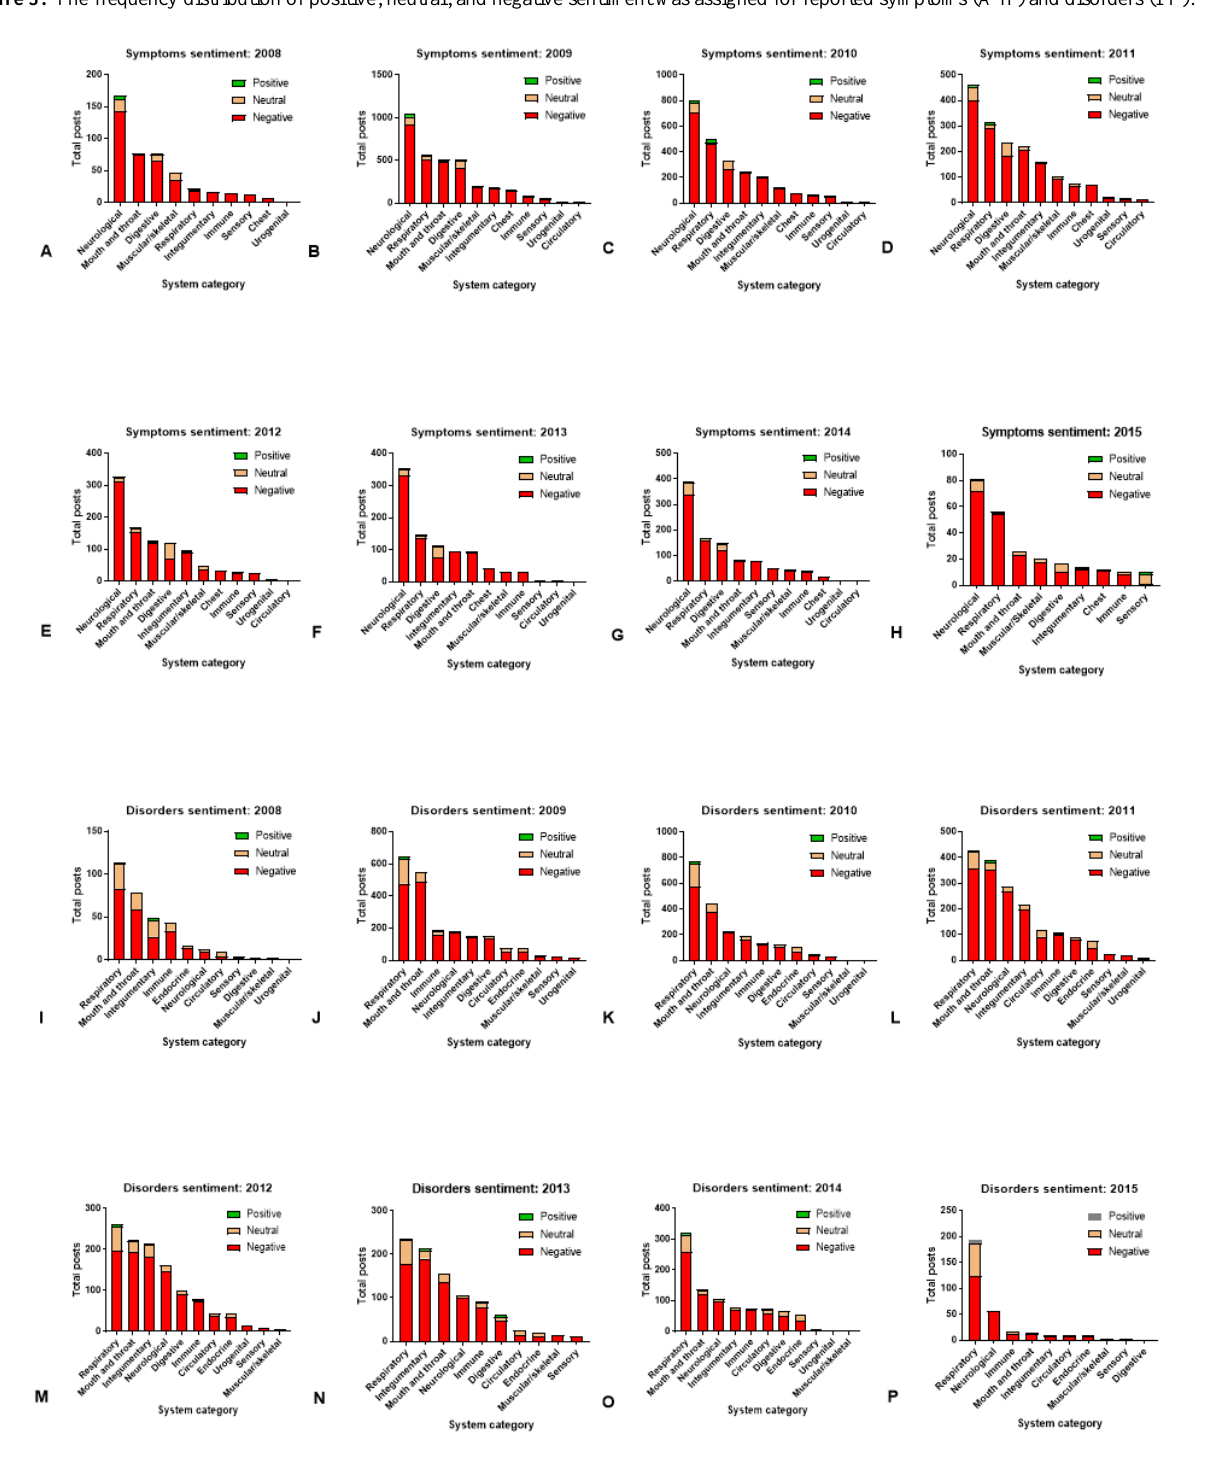
Figure 3. The frequency distribution of positive, neutral, and negative sentiment was assigned for reported symptoms (A-H) and disorders